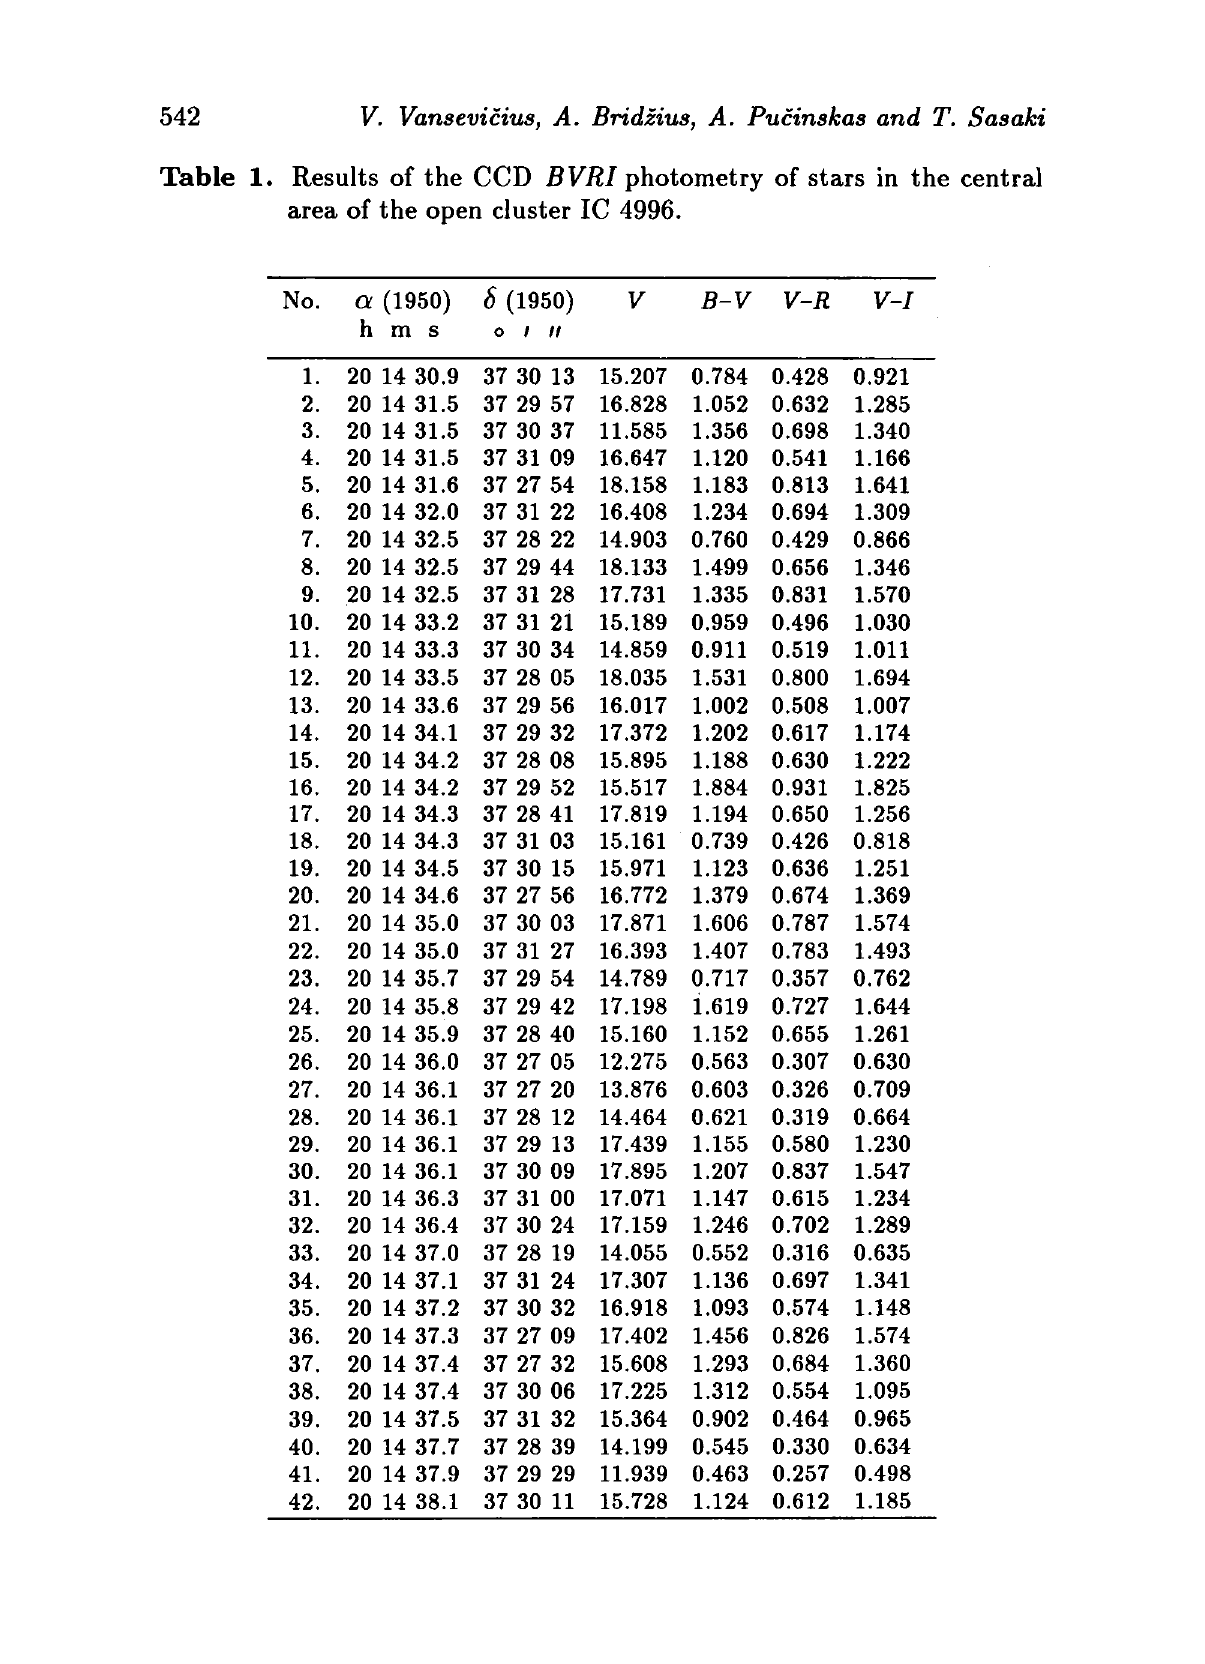
Table 1. Results of the CCD Β VRI photometry of stars in the central area of the open cluster IC